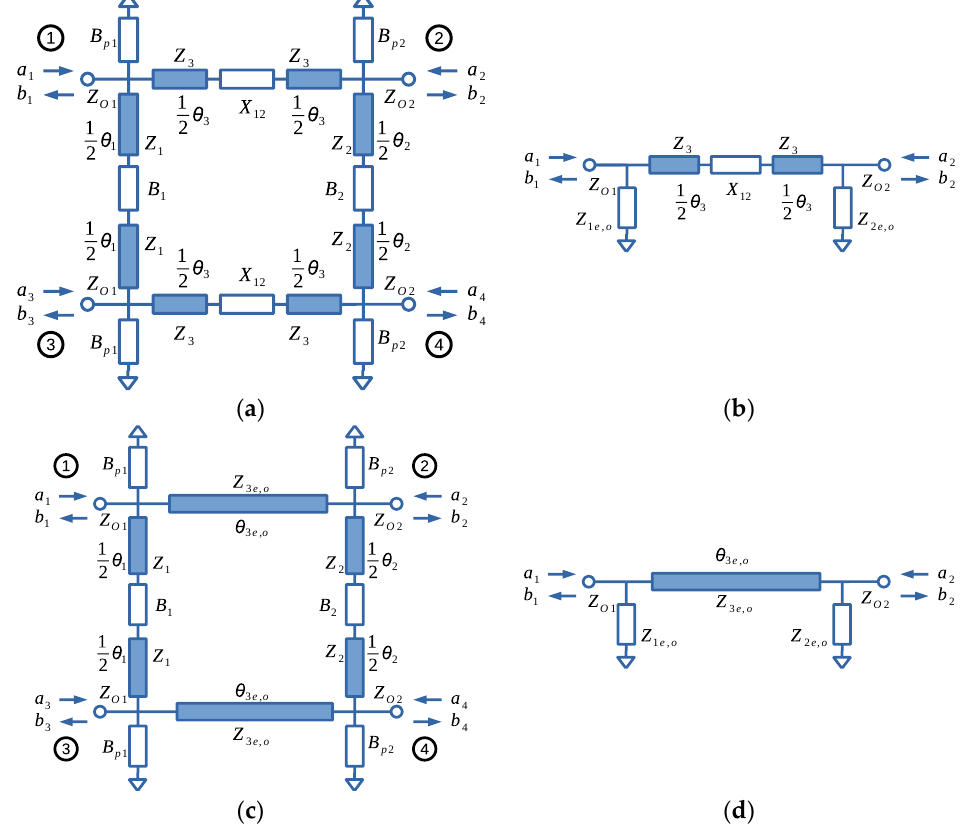
Figure 2. Equivalent circuit of: ( a ) the original general ring-type four-port with lumped-distributed elements [33]; ( b ) the original even- and odd-mode two-port equivalent circuit; ( c ) the modified general ring-type four-port with lumped-distributed elements [33]; ( d ) the modified even- and odd-mode two-port equivalent circuit.